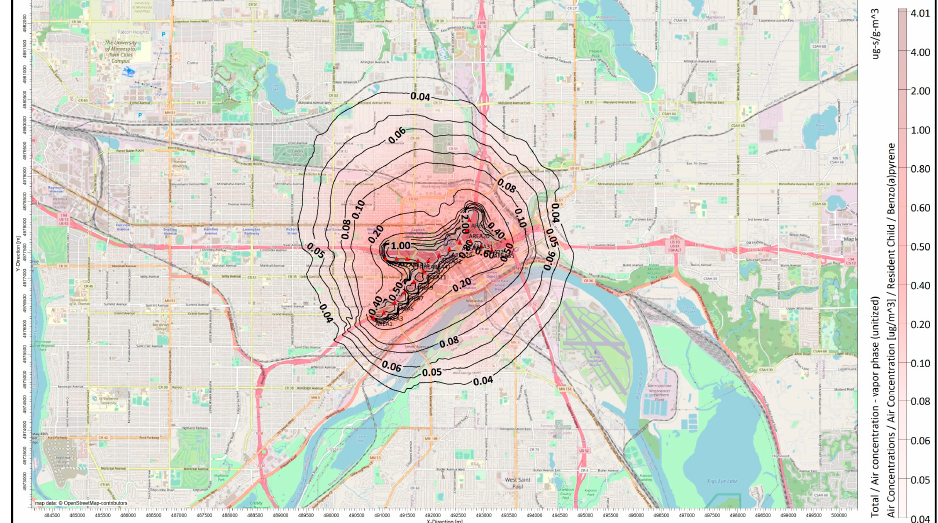
Figure 11. BaP Annual Air Concentration—Vapor Phase (Unitized) Contour Plot overlaid on Open- StreetMap Satellite Imagery (OpenStreetMap, n.d.). Unit used in contour is µg-s/g-m 3 .